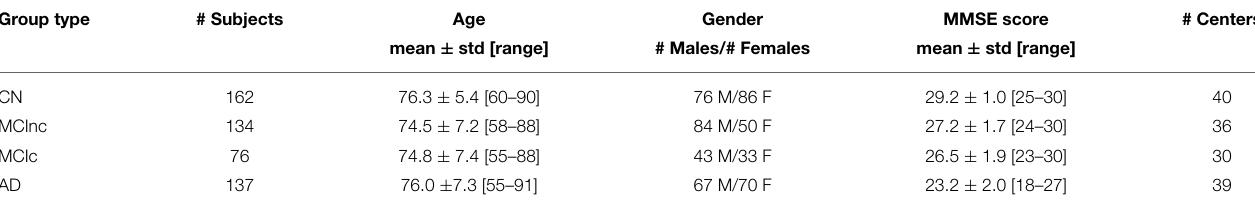
TABLE 1 | Demographic and clinical data for the considered groups of participants. Group